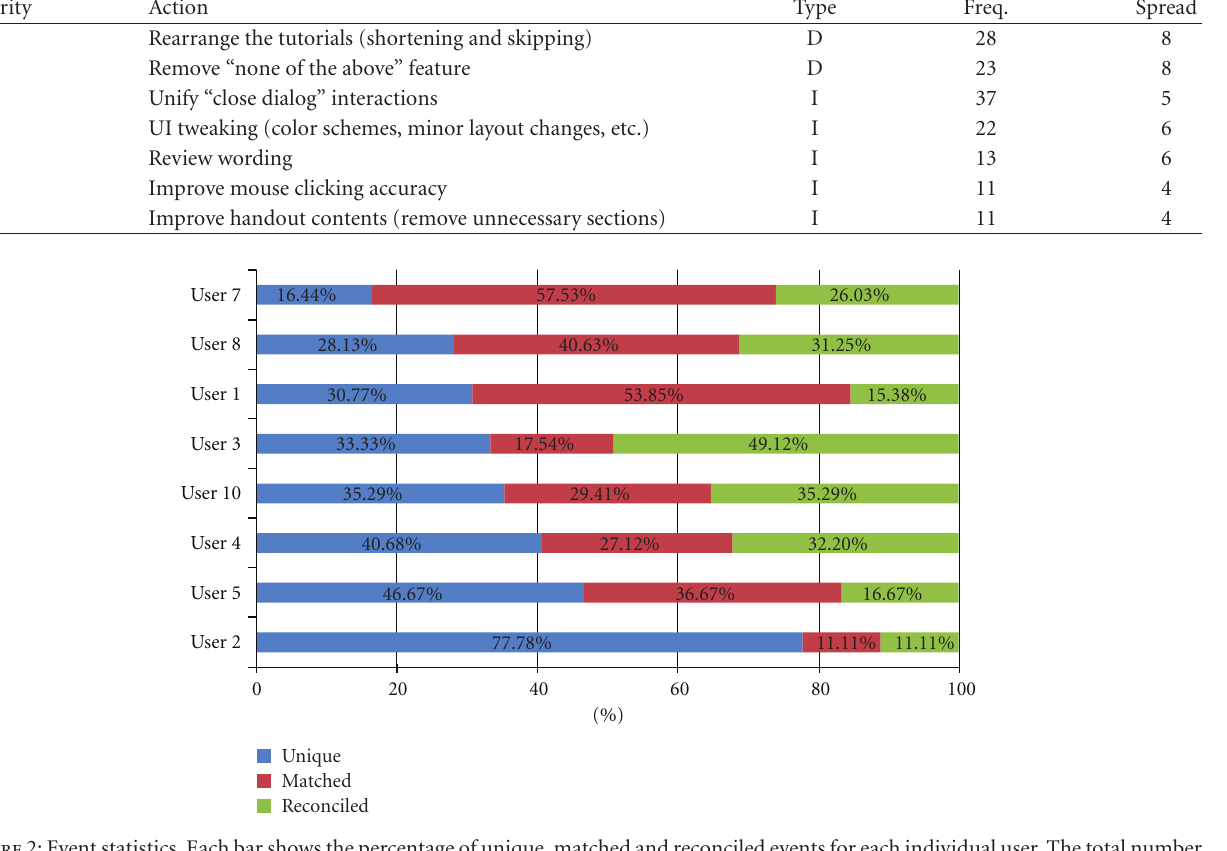
Figure 2: Event statistics. Each bar shows the percentage of unique, matched and reconciled events for each individual user. The total number of events for each user is shown in parenthesis.